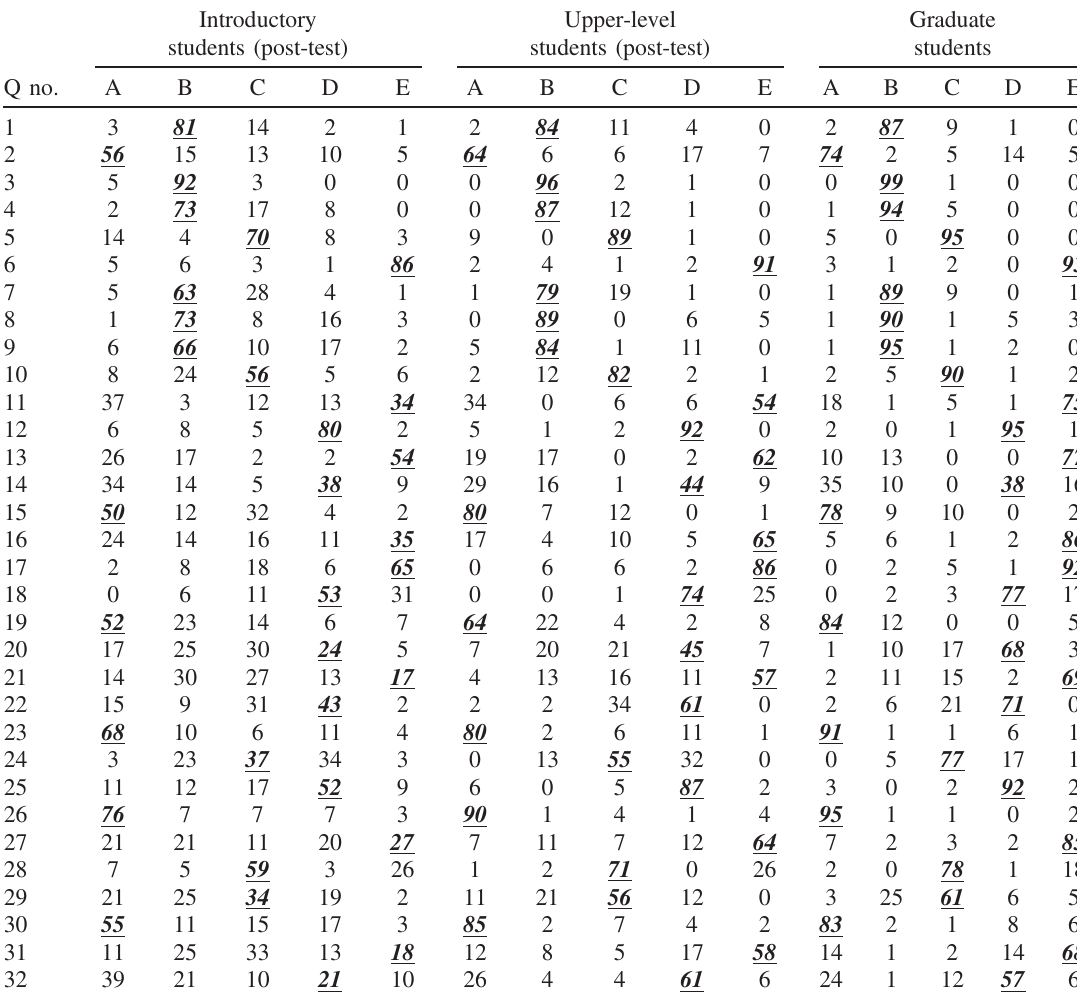
TABLE II. Percentages of introductory students and upper-level students who selected each answer choice on each question on the CSEM after instruction (post-test). The bold and underlined numbers represent the correct answer for each question